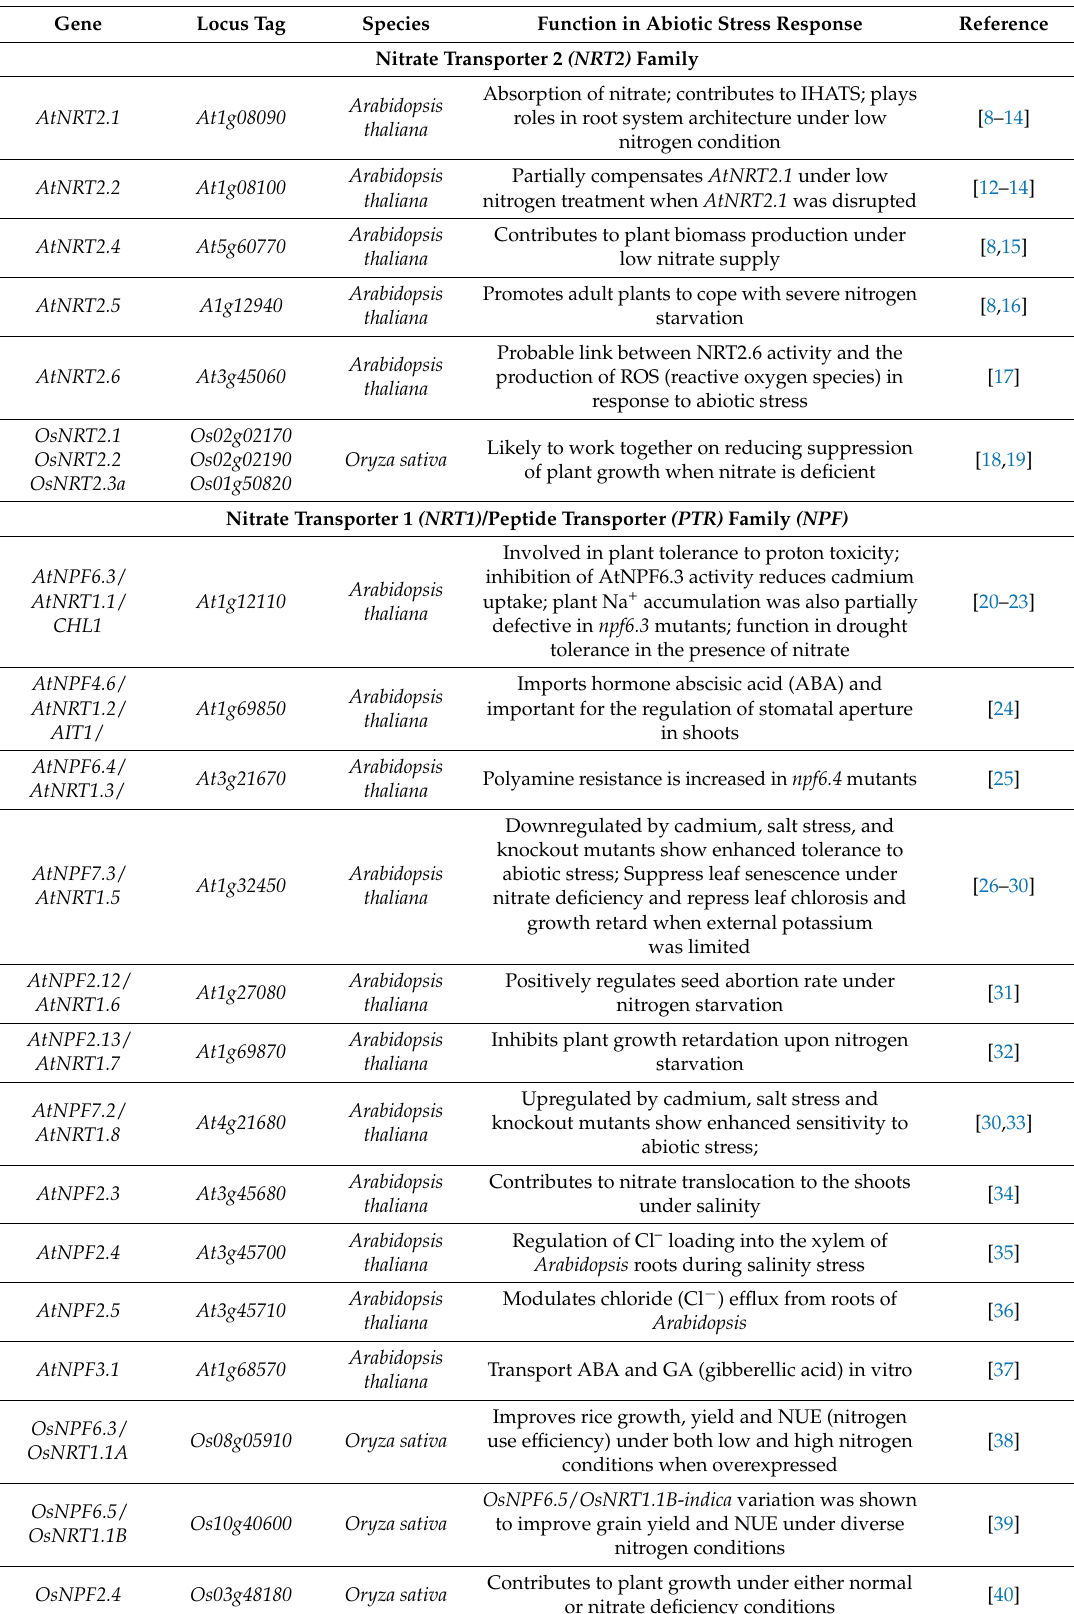
Table 1. Summary of nitrate transporters involved in abiotic stress